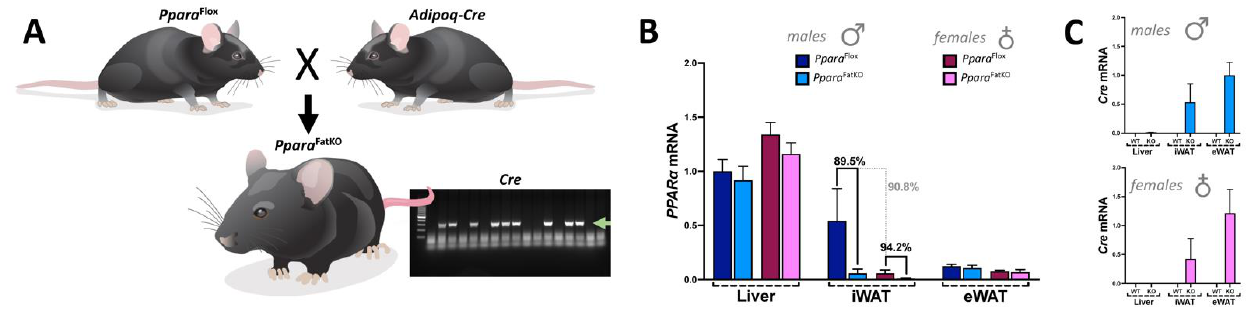
Figure 1. Generation of the Ppara FatKO and Ppara fl/fl mice. ( A ) Ppara fl/fl and Adipoq-Cre mice were mated to generate the Ppara FatKO . The green arrow in the gel indicates the Cre band. Real-time PCR expression of PPAR α ( B ) and Cre ( C ) in male and female Ppara FatKO and Ppara fl/fl mice.